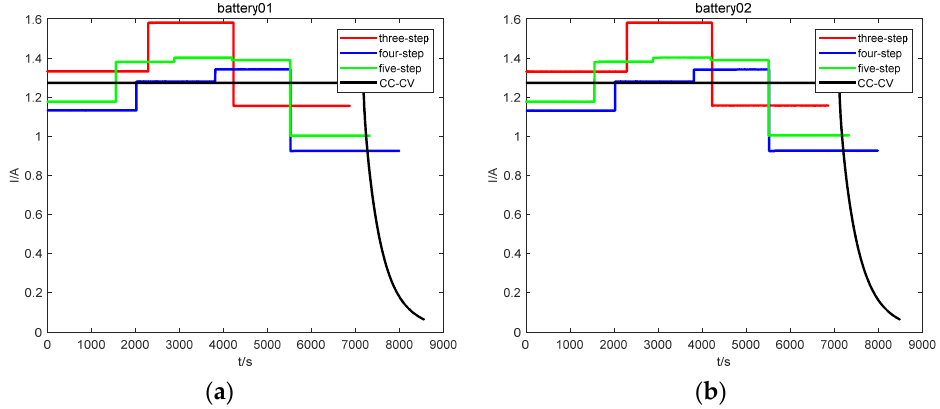
Figure 14. Current comparison diagrams between the optimized charging strategy and the constant current-constant voltage charging strategy: ( a ) Battery01; ( b ) Battery02.